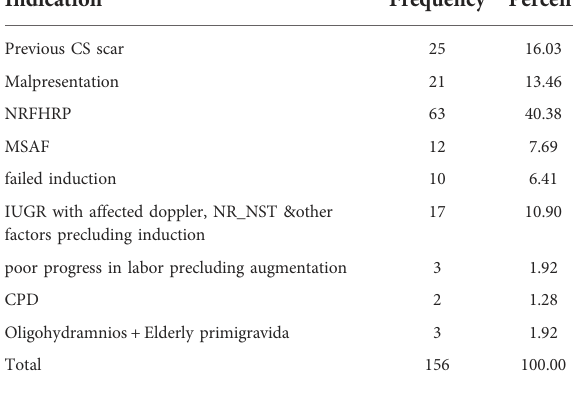
Table 5 Indications for cesarean delivery among participants, 2021 Indication